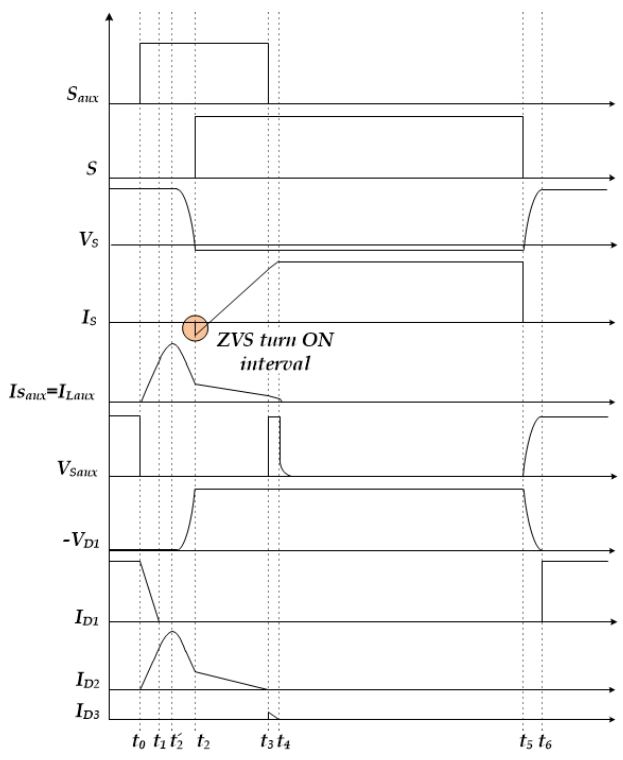
Figure 3. Equivalent topological circuit theoretical waveform of the proposed tandem